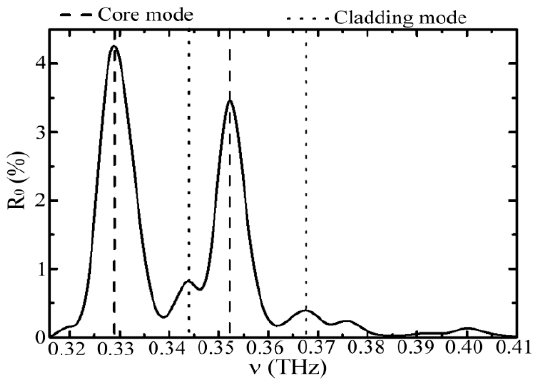
Figure 2. Reflectivity spectrum of a blank waveguide-gas-sensing (WGS) unit in the experiment.